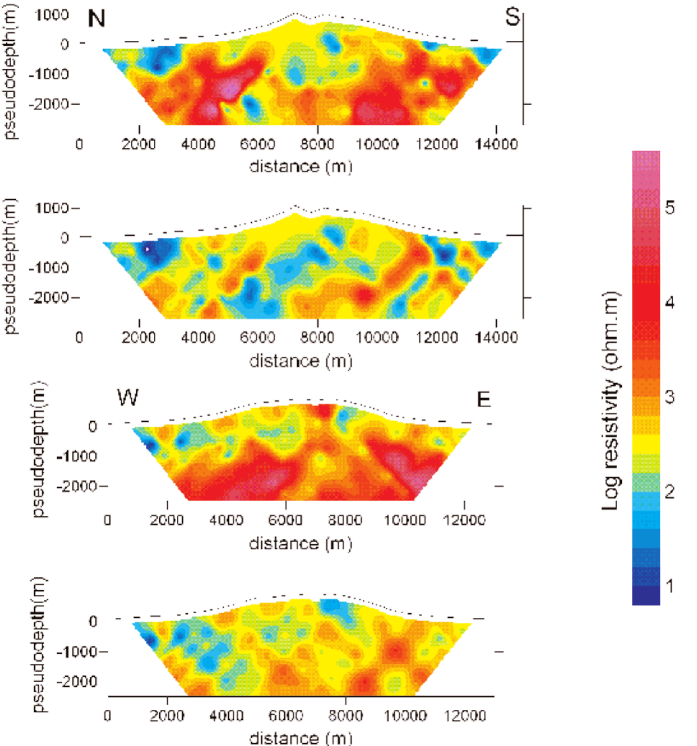
Fig. 3. Pseudosections of the N-S and E-W DD ERT profiles and responses of the best fit N-S and E-W mod- els shown in fig. 2. Data are fitted with an rms of 3.9 and 3.6 respectively.